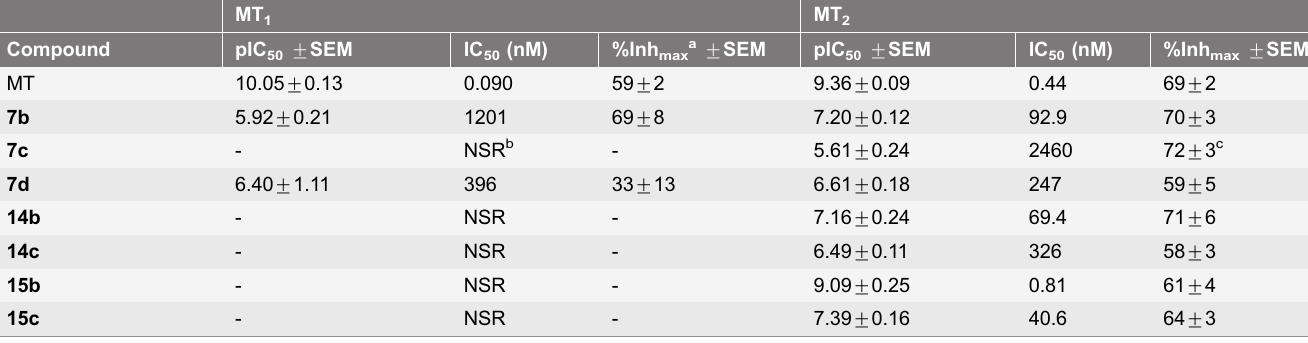
Table 3. Isoquinolinone-induced inhibition of cAMP production in MT 1 -CHO and MT 2 -CHO cells.